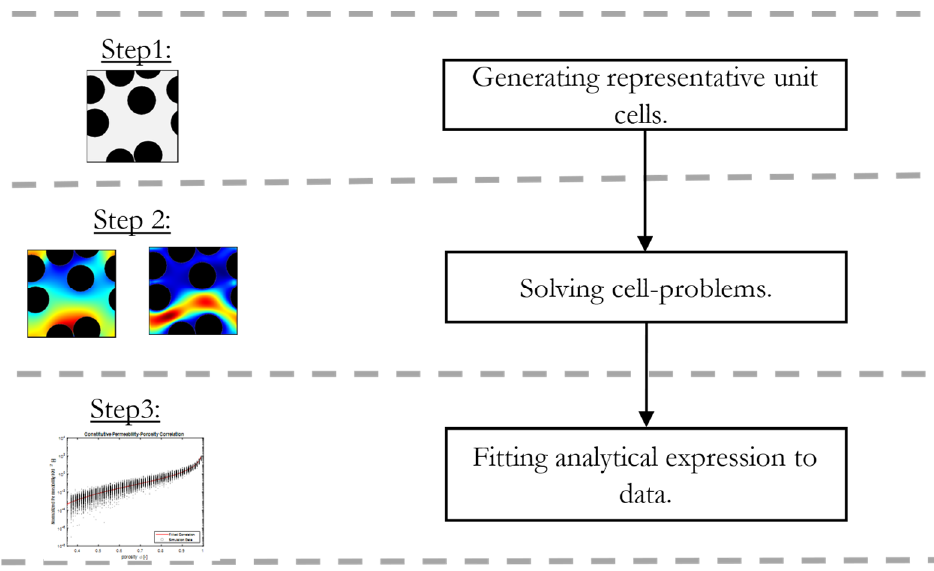
Figure 7. Schematic flow chart to determine constitutive correlations for mass transport in fibrous media.